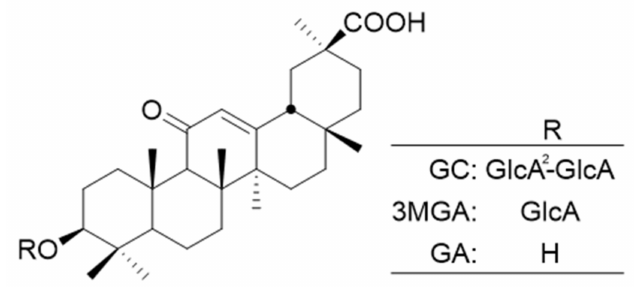
Figure 3. Chemical structures of GC, 3MGA, and